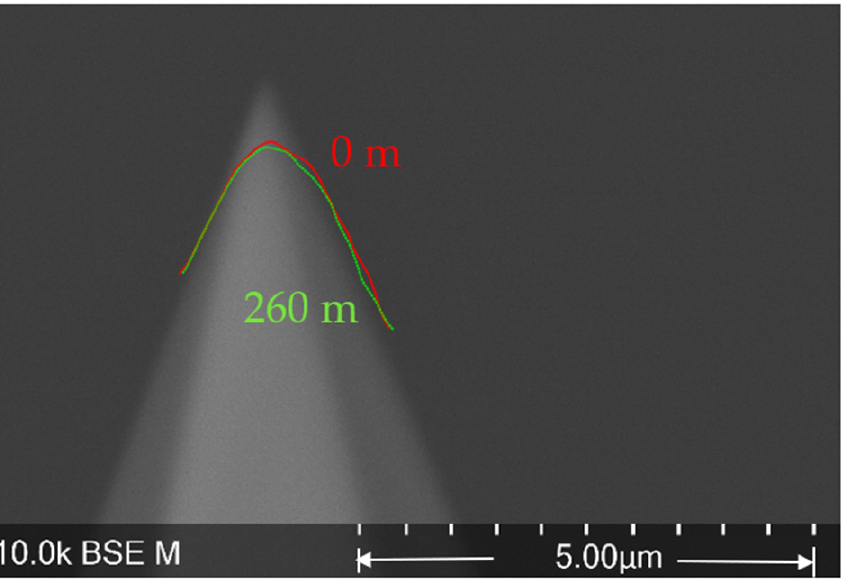
Figure 9. The tip geometry variation after 260 m of sliding over a roughness standard surface with Ra 0.05 µm.